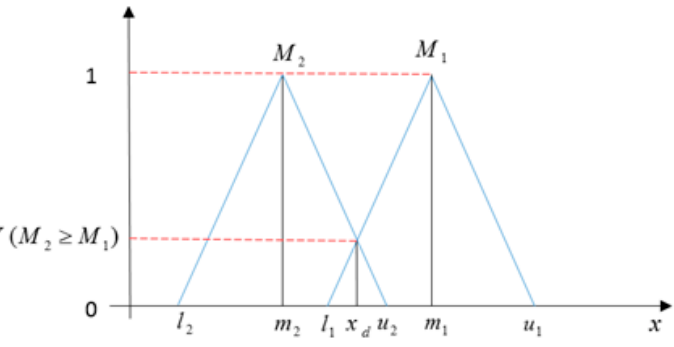
Figure 9. The degree of possibility V ( M 2 ≥ M 1 ) . Table 3. The applied triangular fuzzy number of linguistic variables.